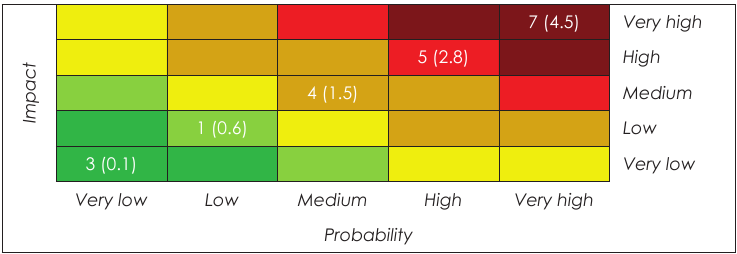
Table 11: Summary of risk P-I across the PLC in Case 1